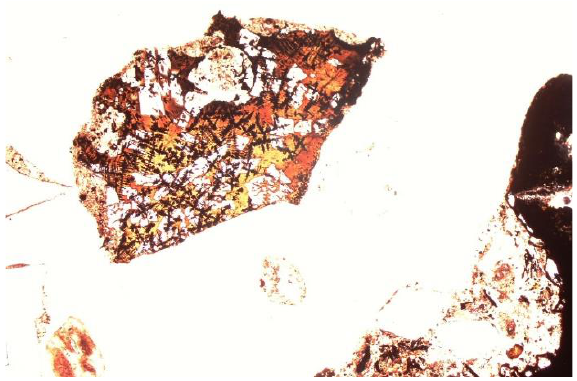
Figure 23. Metallic substance. Unburned fragment of anthropogenic origin. SP2 sample, thin section, 1P, 100×, transmitted light.